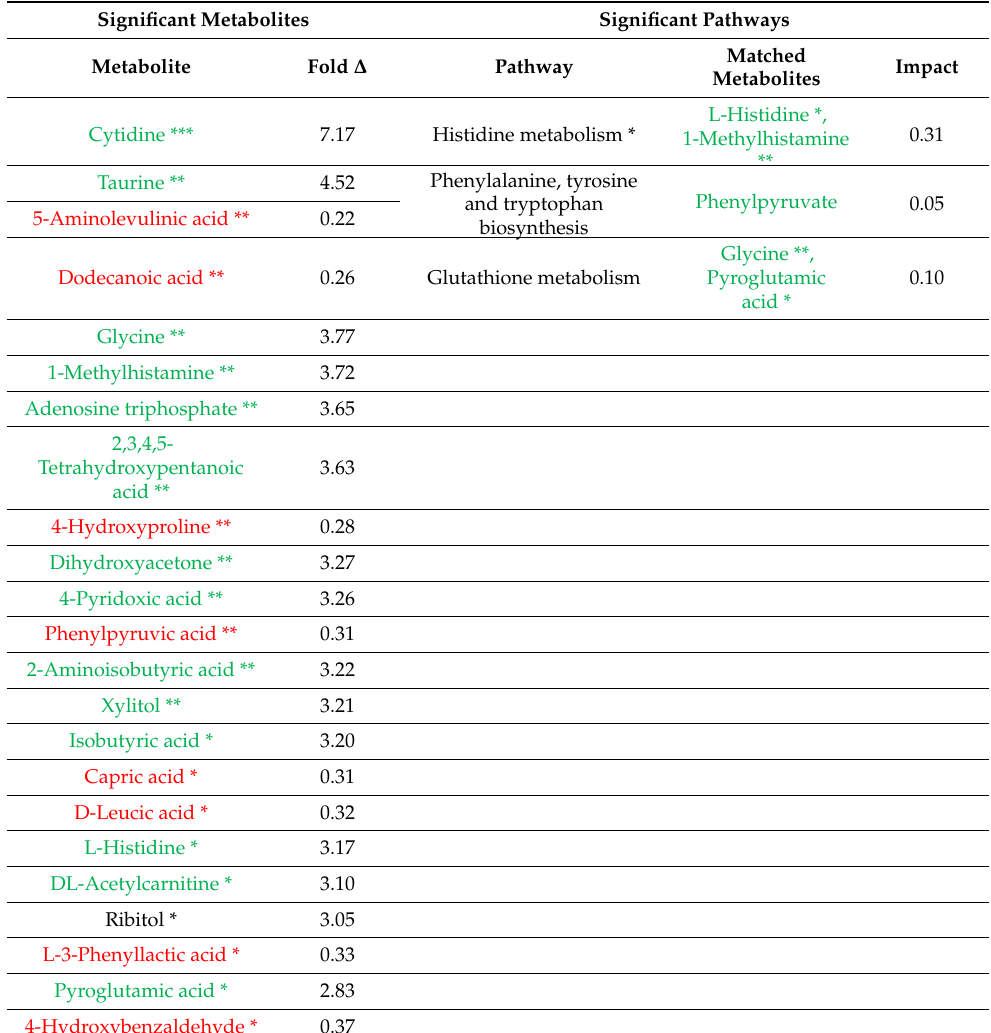
Table 1. Metabolites and their pathways which are different between autism spectrum disorder and control